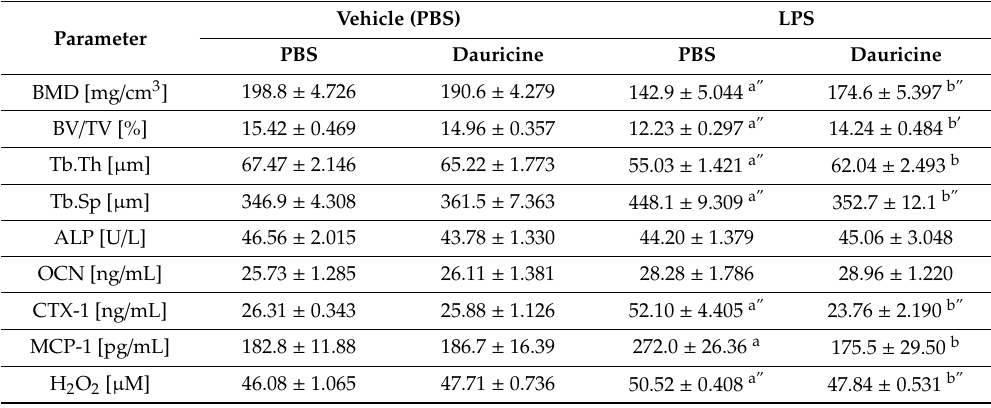
Table 1. Trabecular microarchitecture and biochemical markers of LPS with or without dauricine treatment in